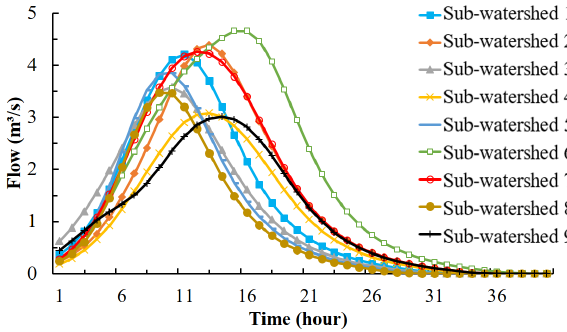
Figure 9. DUH for the Qin River